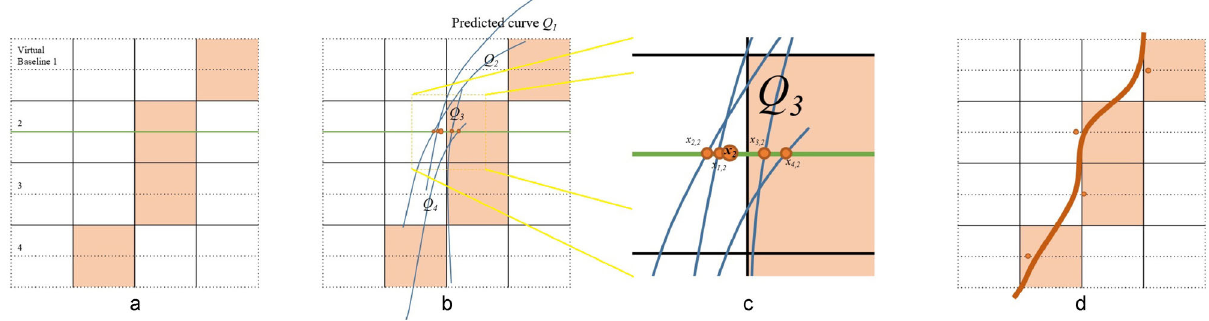
Fig. 3 The curve aggregation pipeline. (a) shows a part of an input picture. There are 4 × 4 grids, and each grid indicates one pixel in the output feature maps and a square area in the original picture. The green horizontal line is the virtual baseline we are trying to solve the intersection point on. A grid is in orange only if the grid has the maximum M i on a horizontal vertical baseline. (b) shows the separate curves Q i generated from the four orange grids. These curves have intersections x i, 2 with the green horizontal baseline, which are shown in (c). These intersections are summed after being weighted by their confidence M and the distance between their baselines and the green one, generating the final answer x 2 on the green baseline. Repeat this process, we get all the x j s, and then we perform a simple post-process to draw the predicted lane boundary in orange shown in